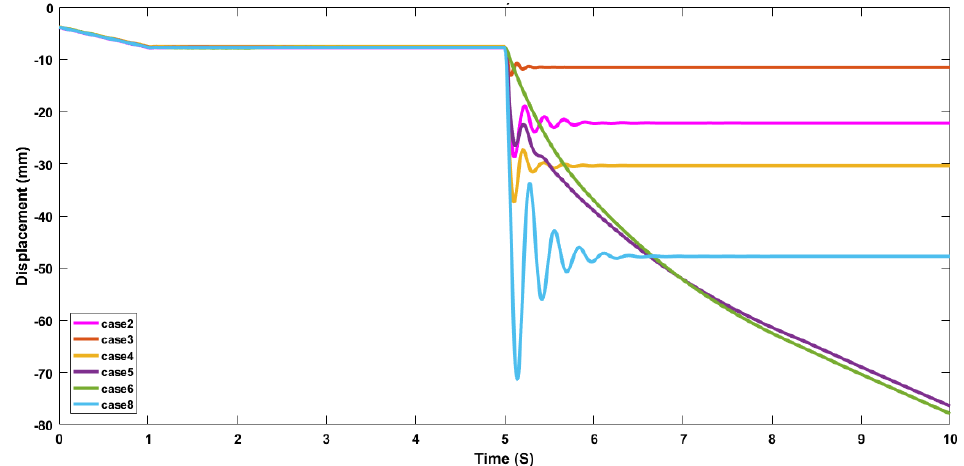
Figure 17. Vertical displacement at column removed position due to column loss in story thirteen.